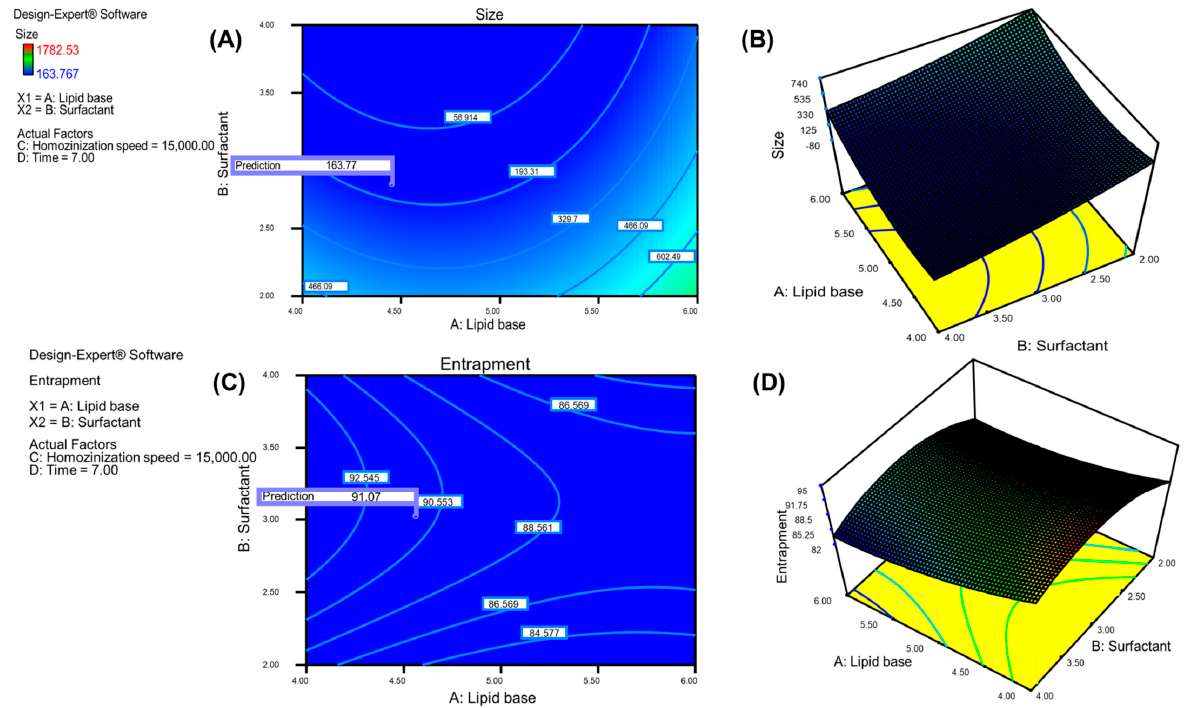
Figure 5. CCD optimization graphs illustrating the effect of independent variables PS and EE. ( A ) The contour plot graph of factors effecting on PS. ( B ) The three-dimensional graph of factors effecting on PS. ( C ) The contour plot graph of factors effecting on EE. ( D ) The three-dimensional graph of factors effecting on EE.